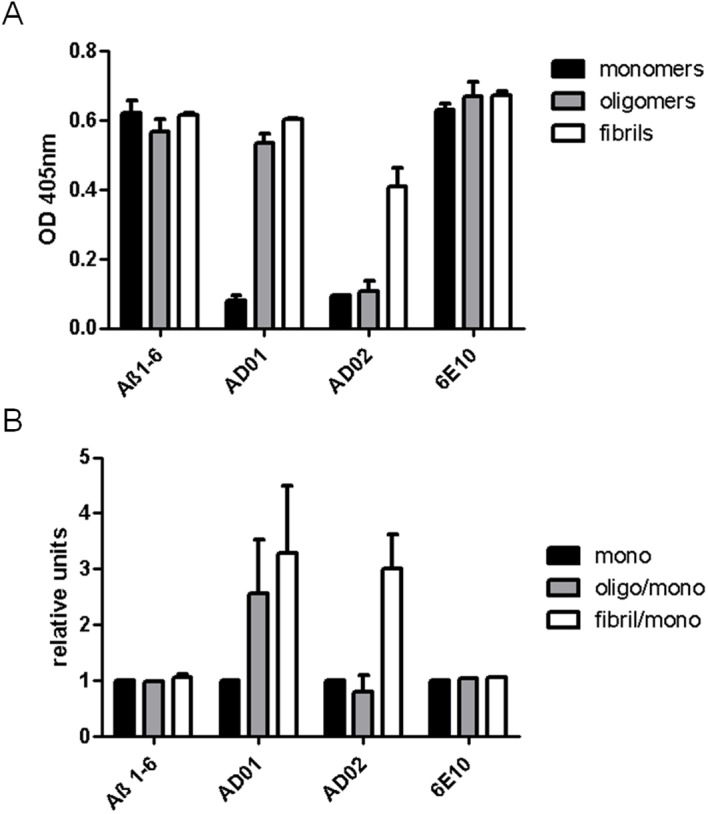
AFFITOPE induced antibodies differ in their reactivity towards aggregated forms of Aβ.A) Reactivity of Aβ1-6-, AD01- and AD02-induced Abs towards Aβ in various aggregation states. Bars represent the means of OD values (at 405nm) of individual plasma samples (duplicates) derived from single animals immunized with Aß1-6, AD01 or AD02;. B) Relative units of values from monomeric- and either oligomeric- or fibrillar Aß detection by plasma samples from Aß1-6- or AFFITOPE-treated animals are depicted (mean+/-SEM, n = 5 samples/vaccine). Levels around one indicate a similar OD whereas values above one indicate a predominant binding to either oligomers or fibrils as compared to monomeric Aß1-42. Reactivity of sera was tested against seedless monomeric, oligomeric and fibrillar Aß1-42, respectively. Purity of the preparations was comparable and exceeded 90%. The monoclonal Ab 6E10 (Signet) was used as positive control.